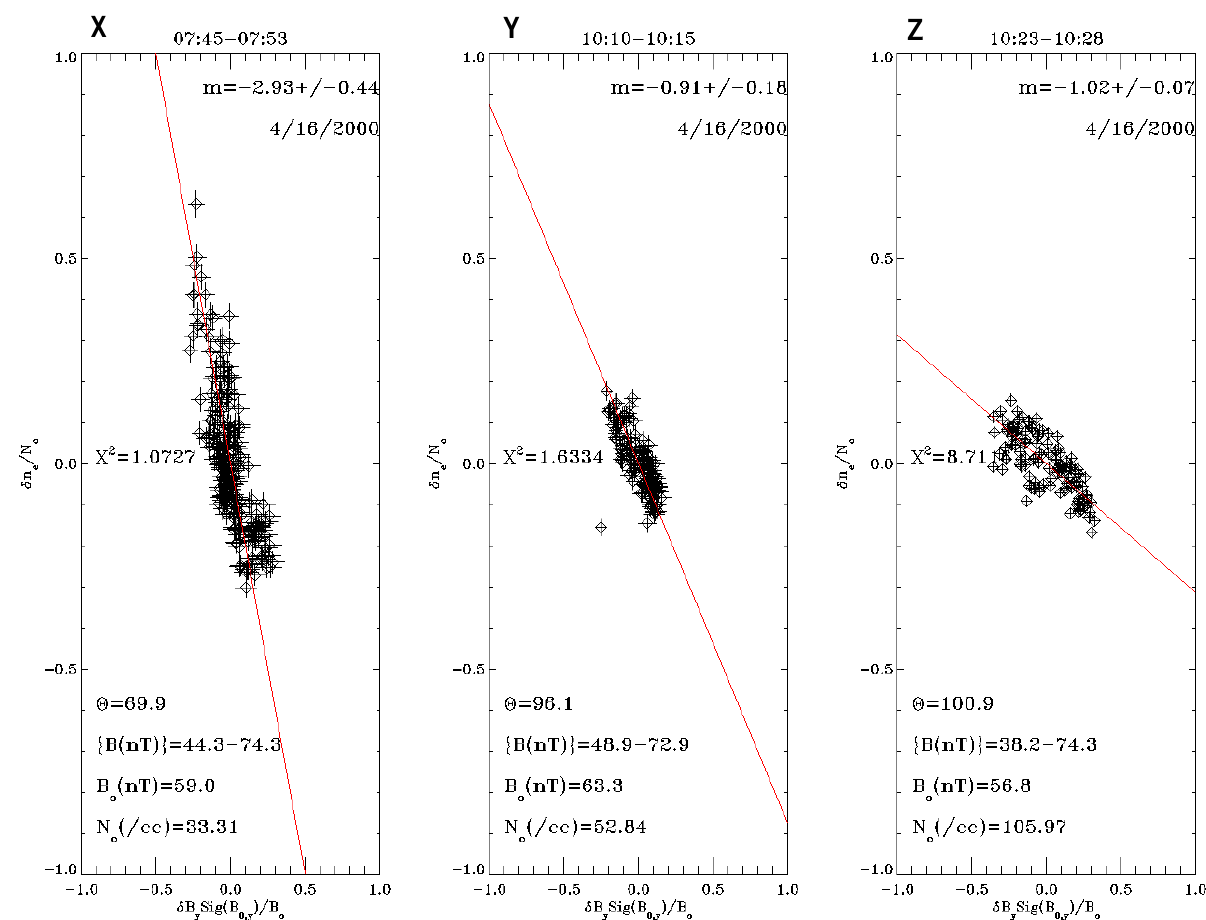
Fig. 12. Linear regression fits for three intervals of 16 April 2000, labeled X, Y, and Z in Fig. 5. See caption for Fig.